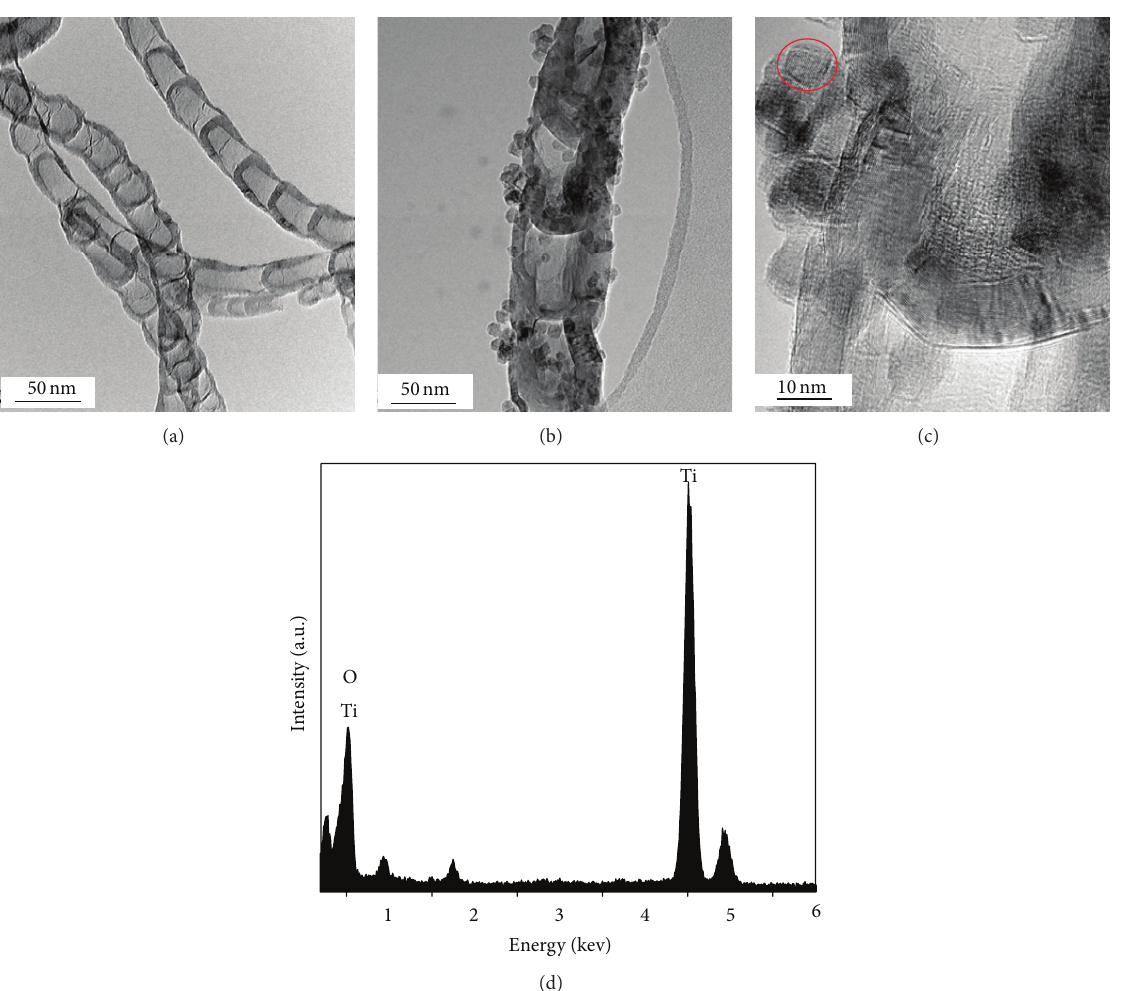
Figure 3: TEM images of bare CNx (a), low-magnification TEM image (b), high-magnification TEM image (c), and EDS spectrum of 10wt% TiO 2 -CNx composites (d).